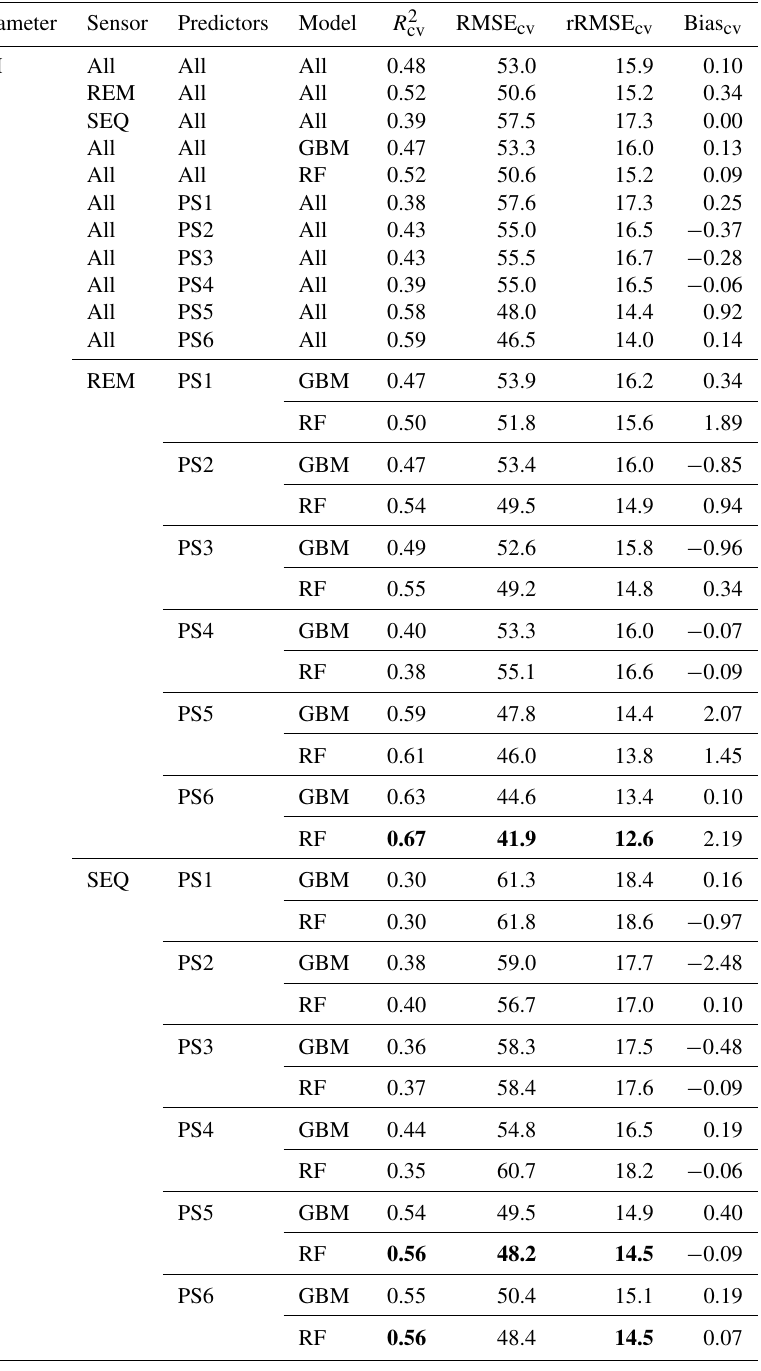
Table 4. Overview of the DM models and cross-validation evaluation metrics for all combinations of sensors (REM, SEQ), predictor sets (PS1: raw reflectance data, PS2: VI, PS3: raw reflectance data + VI, PS4: canopy height, PS5: raw reflectance data + canopy height, PS6: raw reflectance data + VI + canopy height), and ML algorithms (GBM, RF). The unit of RMSE cv and absolute Bias cv is grams per square metre. All metric values of single-sensor–predictor set–algorithm combinations are averages of the 10 iterations. Best results per sensor in bold. The first 11 rows per parameter show aggregated median results (e.g. median of all DM models). N obs =